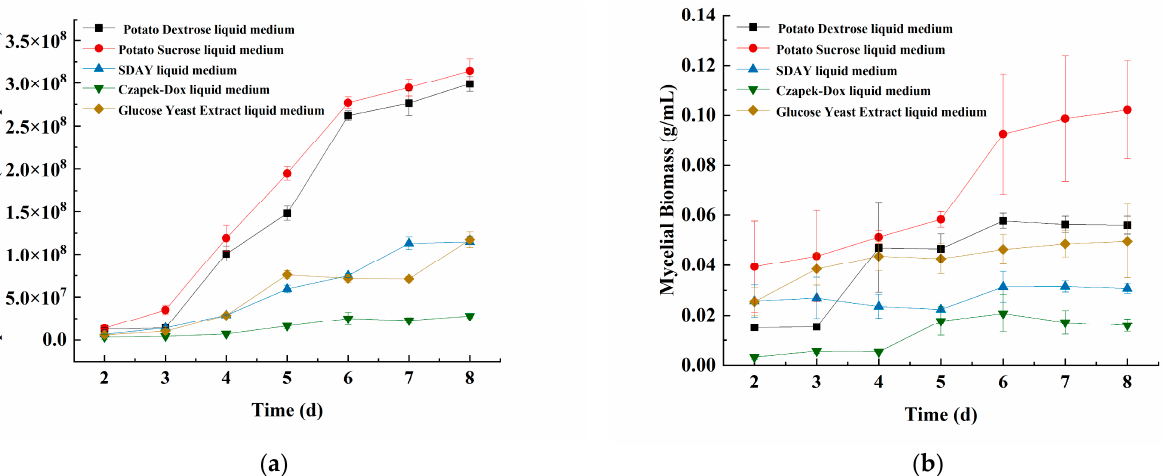
Figure 1. Effects of different medium and incubation time on the ( a ) spore concentration and ( b ) mycelial biomass of strain JMF-01. The data in the figure are the mean ± SEM. The SEM of three repetitions is shown in bars.